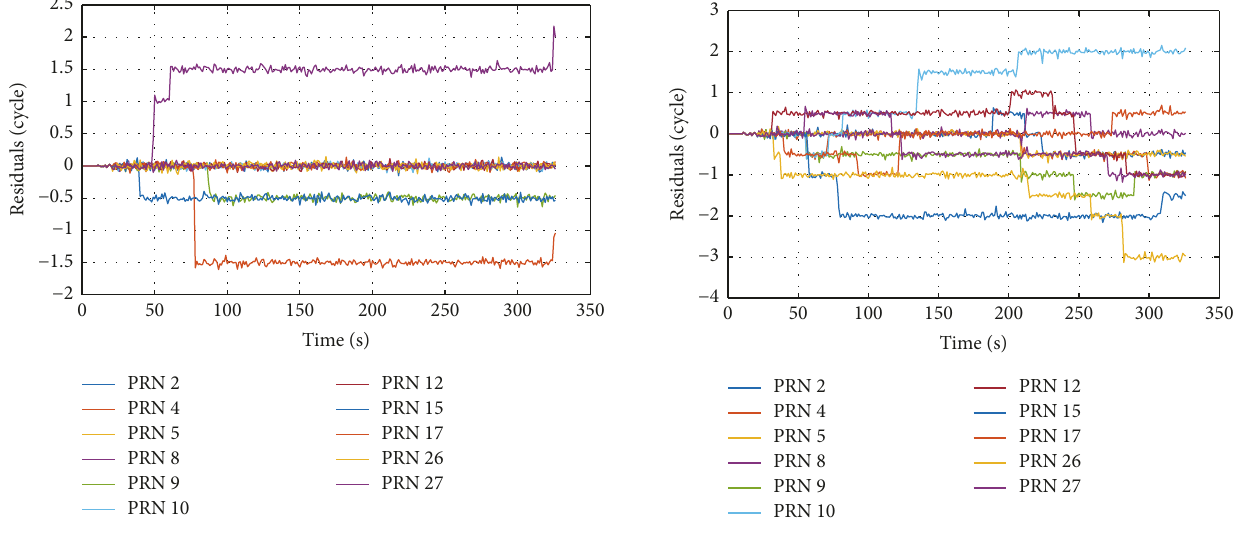
Figure 7: Single difference of carrier phase between 47dB-Hz and 21dB-Hz data sets with PLL.